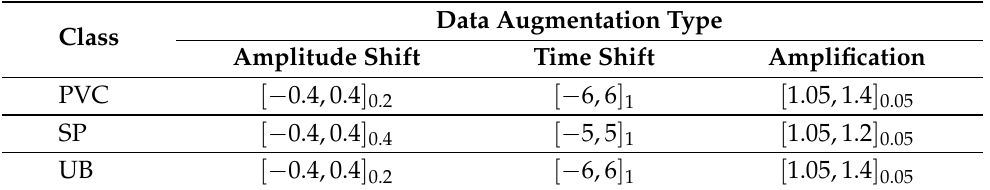
Table 2. Data augmentation applied on ECG5000 dataset in Experiments 1–10 of Table 1.